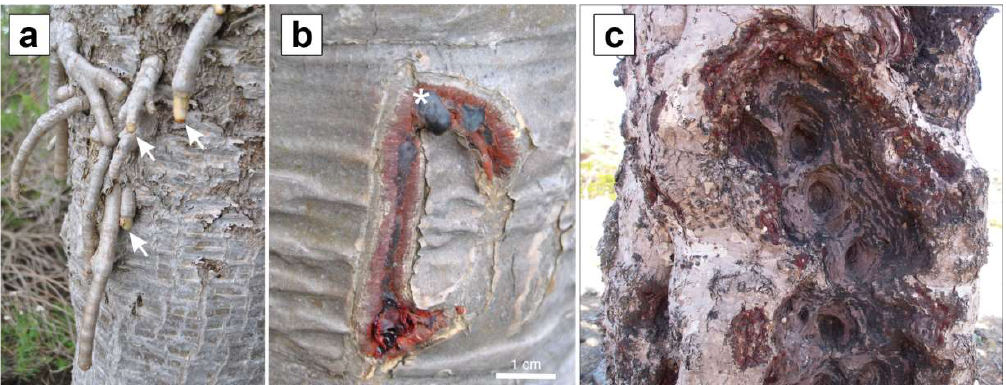
Figure 2. Aerial roots and dragon’s blood of a dragon tree. ( a ) D. draco , aerial roots arising from the stem with growing tips (arrows). ( b ) D. draco , wound of stem with a tear-like drop of dragon’s blood (asterisk). The rest of the wound is covered with resin that can be removed in a form of chips. ( c ) D. cinnabari , ancient wounds tapping until now.